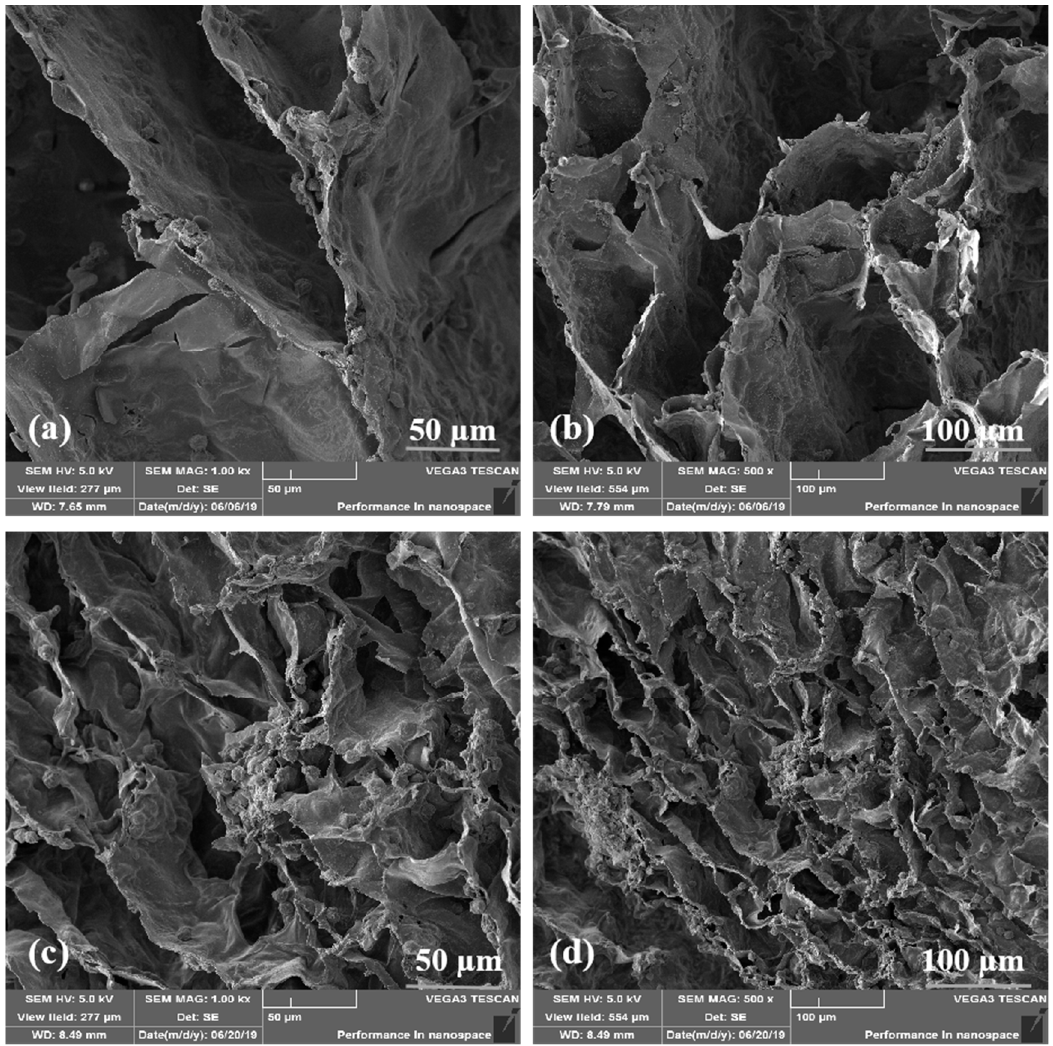
Figure 7. Human neuroblastoma SH-SY5Y cells encapsulated in the alginate-gelatin-interpenetrating polymer network (A-G-IPN) after freeze-drying. ( a ) A scanning electron microscopy (SEM) image showing SH-SY5Y cells encapsulated in the A-G-IPN hydrogel after 7 days of an in vitro culture. ( b ) A magnified image of ( a ). ( c ) A SEM image showing SH-SY5Y cells encapsulated in the A-G-IPN hydrogel after 14 days of an in vitro culture. ( d ) A magnified image of ( c ).